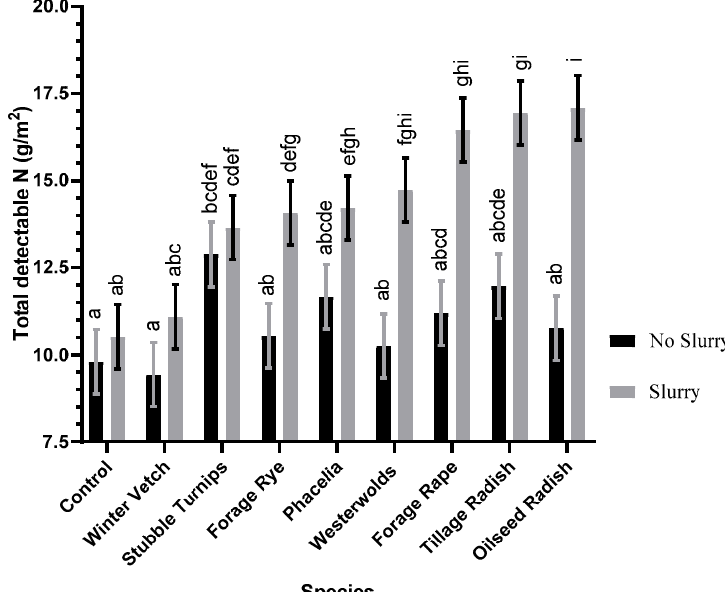
Figure 5. Total detectable N for each cover crop species in response to slurry (g/m 2 ). * Detectable N = Spring barley grain, straw + chaff N offtake + SMN. The bars represent the species mean for both treatments of slurry (N = 3). Error bars represent Standard Error (SE). Letters represent significant differences between cover crops using Fisher’s post-hoc test 0.05 LSD = 2.68. Means that do not share the same letters are significantly ( p < 0.05) different.